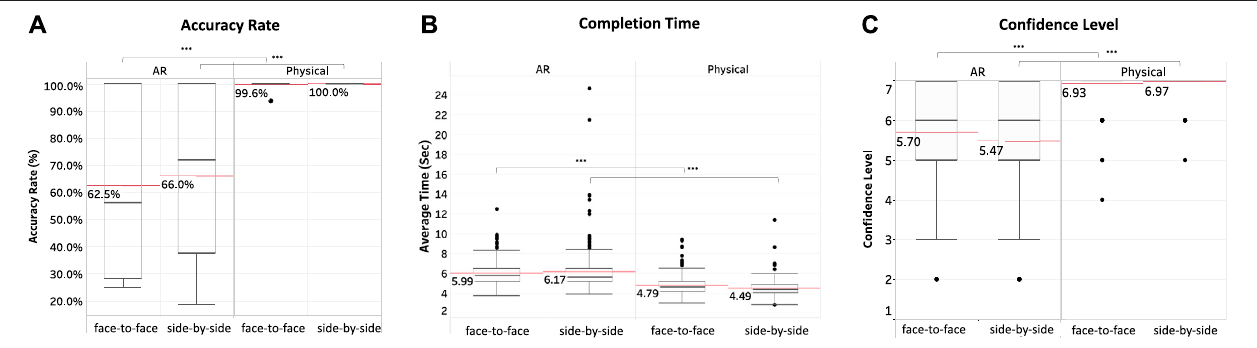
FIGURE 6 | Overall results for accuracy rate (A) , completion time (B) and con fi dence values (C) . Red lines with data labels indicate mean values, while black lines indicate median values.